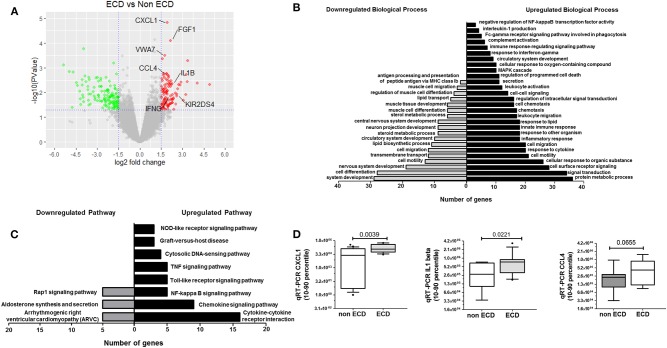
Comparative Transcriptomic analysis of SVF from ECD (n = 5) and non-ECD (n = 5) patients. (A) Volcano plot of differentially expressed genes from SVF from ECD and non-ECD. Log2 Fold Change value obtained by RNAseq plotted against the –log10 of P-value. Genes with a fold change > |1.5| and P < 0.05 were deemed to be differentially expressed. P = 0.05 is indicated by horizontal lines. Positive and negative fold change values are reflective of down-regulated (green) or up-regulated (red) genes compared with non-ECD condition, respectively. (B) Fold enrichment over chance for the Gene Ontology Biological process of the Down (gray) and Up (black) gene lists using DAVID (fold change > |1.5| and P < 0.01). (C) Fold enrichment over chance for the KEGG Pathway of the Down (gray) and Up (black) gene lists using DAVID (fold change > |1.5| and P < 0.01). (D) qRT-PCR validation of selected genes expressed a relative levels of specific transcripts detected per 106 GAPDH transcripts [median (25–75% quartile)].